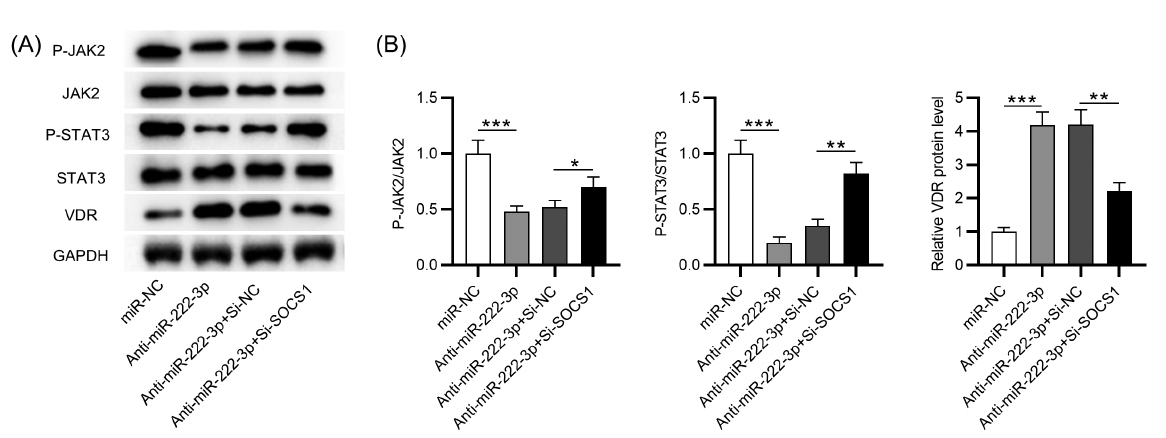
Figure 5. miR-222-3p activates STAT3 signaling and reduces VDR expression by targeting SOCS1 . (A-B) The protein expression of P-JAK2/ JAK2, P-STAT3/STAT3, and VDR in LPS-treated RAW264.7 cells was detected by western blotting. * P < .05, ** P < .01, *** P < .001.